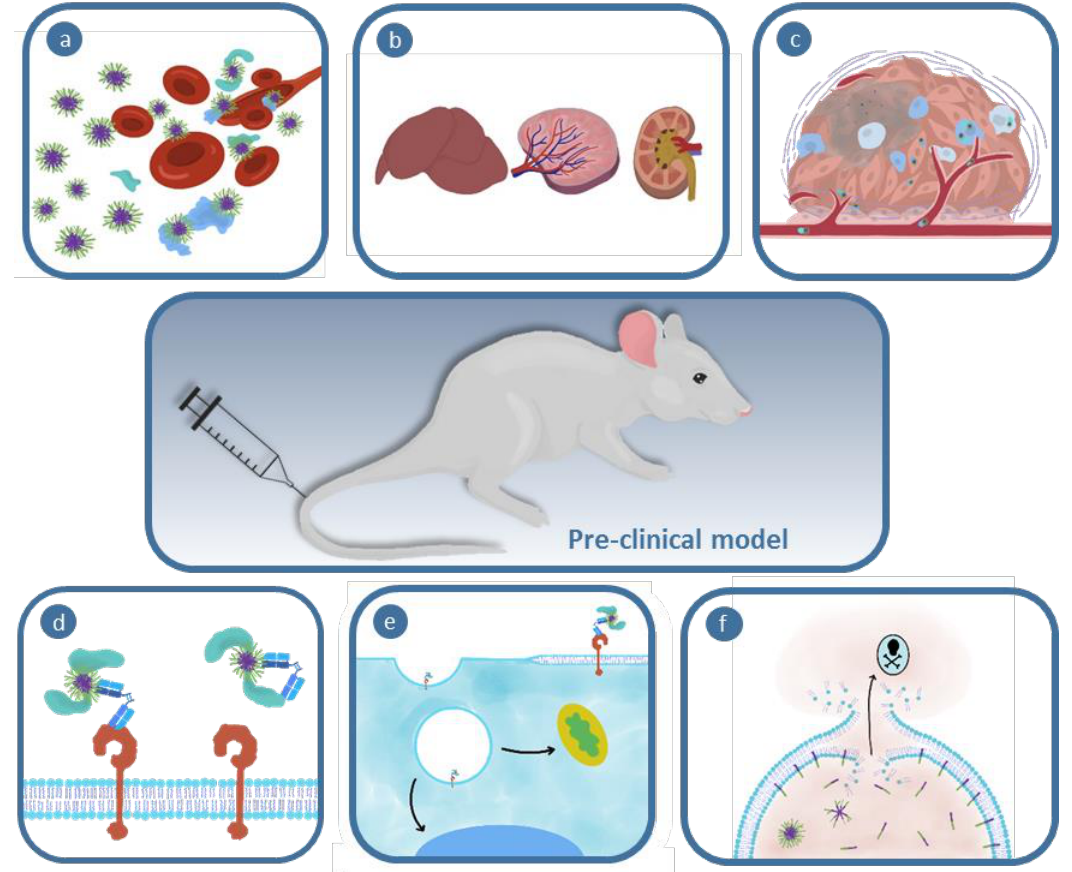
Figure 1. Schematic overview of key biological barriers encountered by polymeric nanomedicines. ( a ) Interactions that occur immediately post-injection with components of blood and plasma; ( b ) biodistribution of polymers and clearance mechanisms; ( c ) barriers that occur at the tumor site and once a material has gained access to the tumor volume; ( d ) receptor accessibility and ability of associated ligands to bind and activate the target surface protein; ( e ) internalization and subsequent intracellular trafficking behaviors; and ( f ) requirement for therapeutic escape from vesicular compartments.